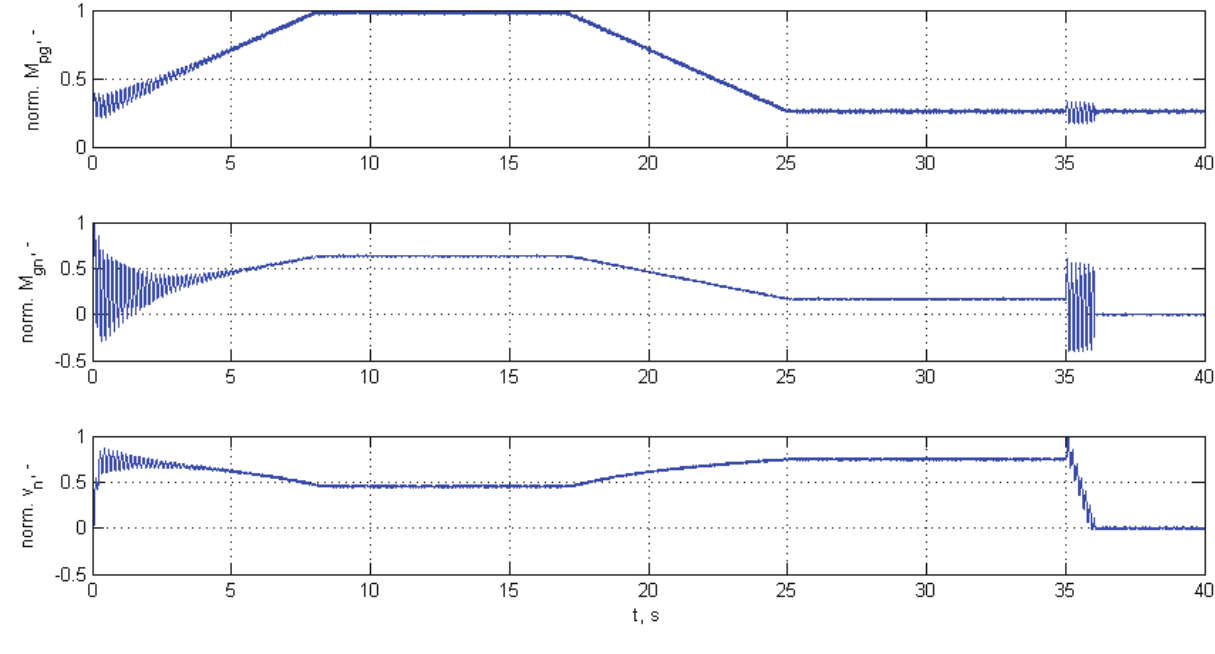
Fig. 9. Results of simulation following scenario S8 considering measurement noise generated by transducers